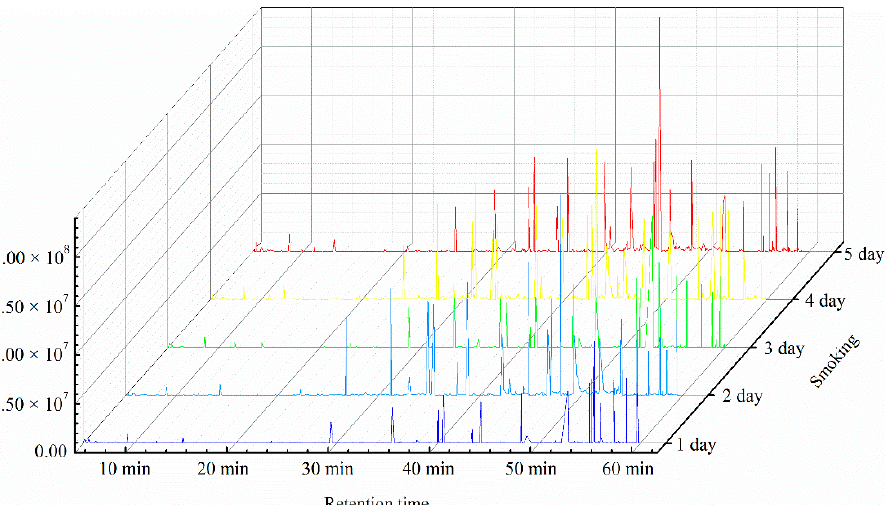
Figure 1. Gas chromatography–mass spectroscopy total ion diagram during the smoking process of Shanxi aged vinegar.